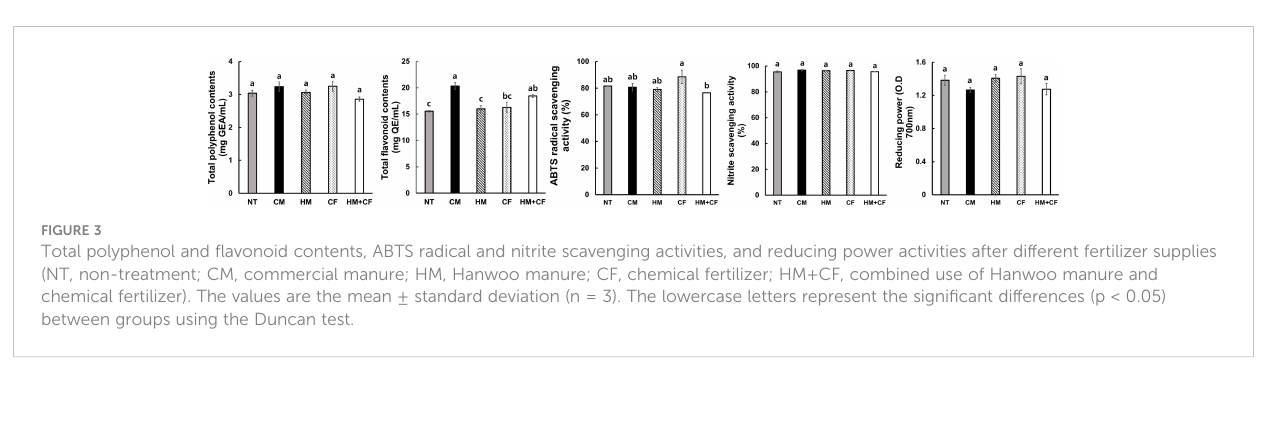
among the different soil samples. Soil microbial ASVs were